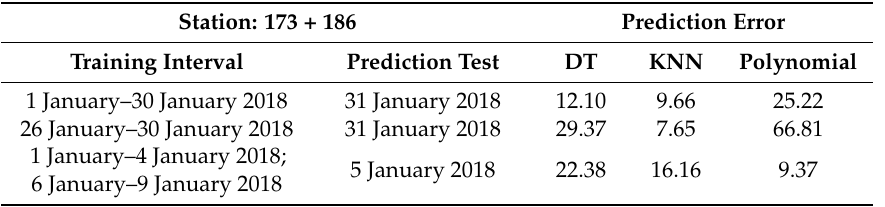
Table 14. Task 4: prediction error of the sensor attribute r_inc coming from both 173 and 186 monitoring station using decision tree, KNN, and polynomial regression machine learning models trained with different time-series interval for the training on the IoT Sensors